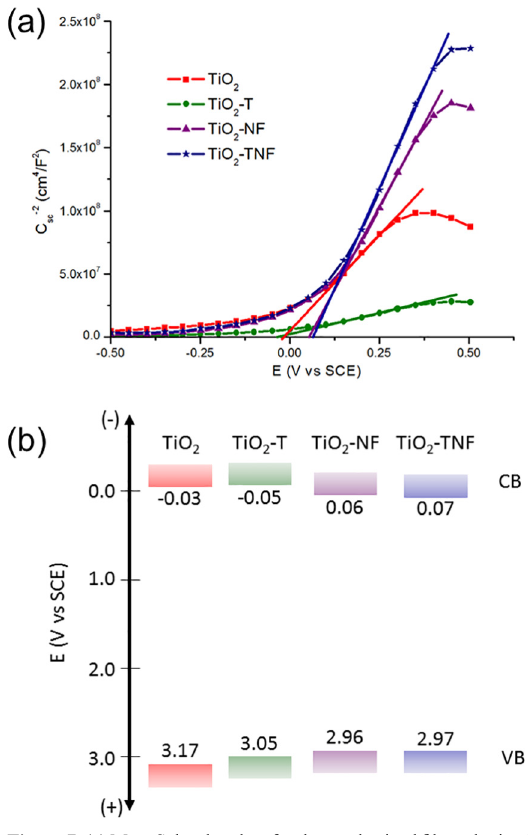
Figure 7. (a) Mott-Schottky plots for the synthesized films obtained experimentally at a frequency of 400 Hz in a 0.1 M Na SO (pH 11), 2 4 and (b) Band diagram derived by assuming the flat band potential of the films as the potential of the conduction band (CB). Valence band (VB) position was estimated by adding the measured band gap energy (Figure 4). ) and flat band potential (E ) estimated Table 2. Donor density (N d fb from Figure 7.